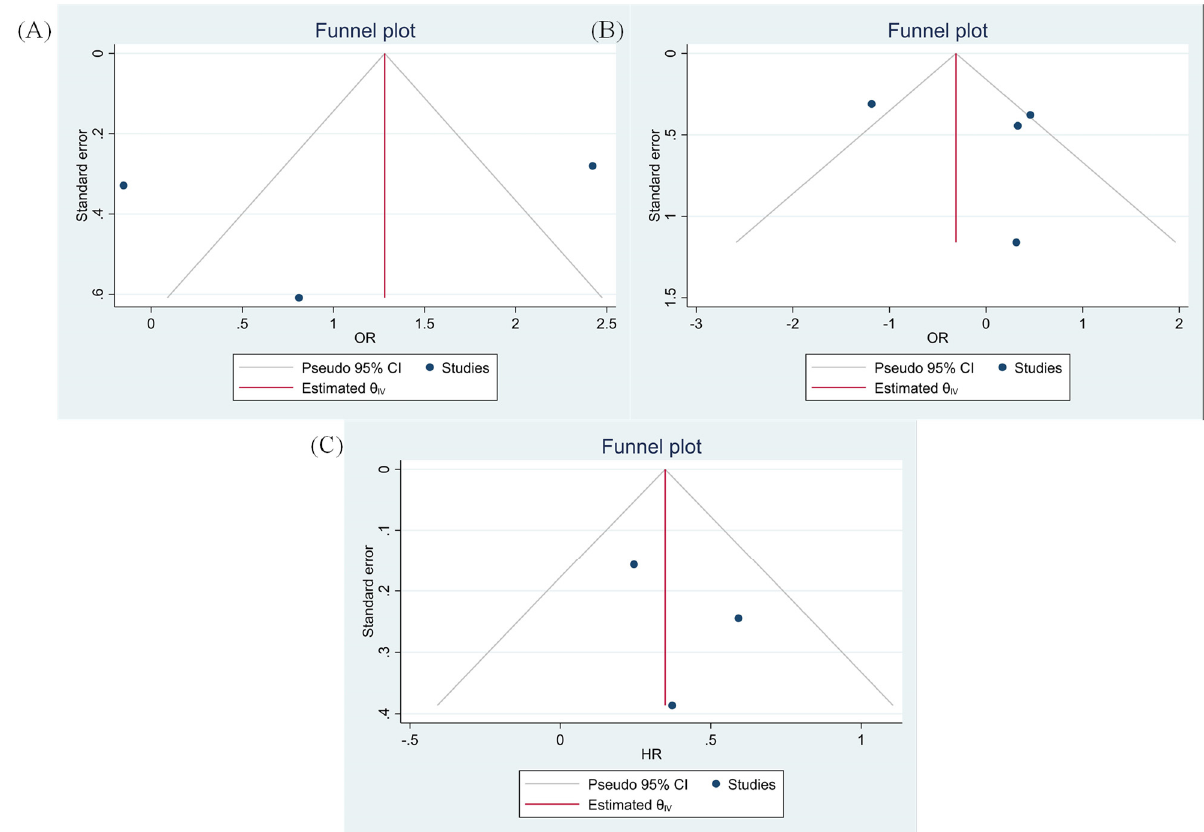
Figure 6. Funnel plots based on TIGIT expression ( A ) tumor size (Egger test p -value = 0.769 and Begg’s test p -value = 0.149), ( B) tumor differentiation (Egger test p -value = 0.579 and Begg’s test p -value = 0.367) and ( C ) OS (Egger test p -value = 0.500 and Begg’s test p -value = 0.500).